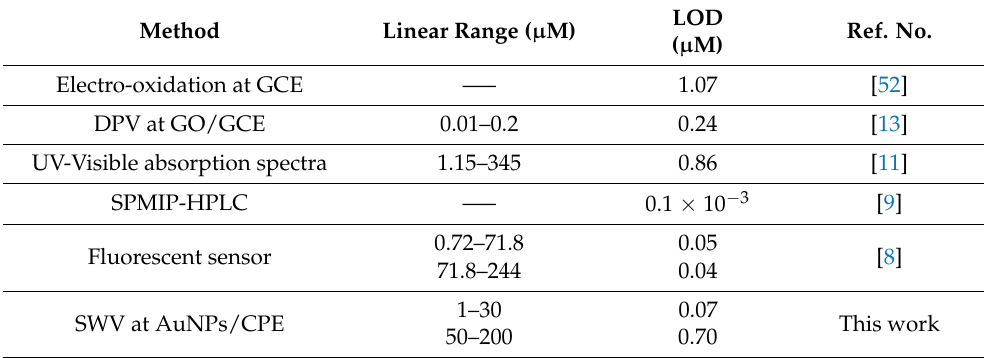
Table 1. Previous studies for the detection of CR